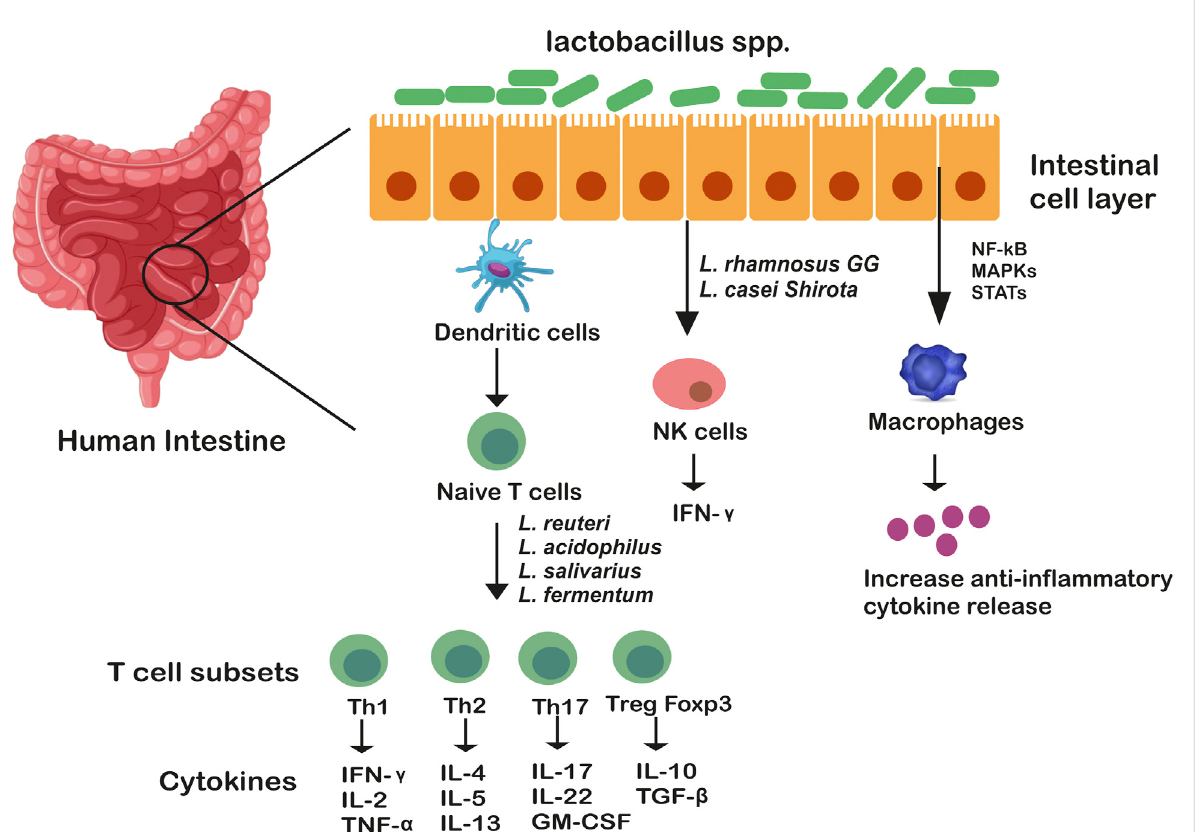
FIGURE 1 Genus Lactobacillus mediated immune modulation in the gut. Genus lactobacillus as whole bacteria or their components communicate through membrane receptors TLR-6 and TLR-2 which are expressed on macrophages and dendritic cells, stimulating T cell subsets differentiation. TheseTcells(Th1,Th2,Th17,Treg)areconsideredasthemastersofin fl ammation. Lactobacillus spp.alsoexerttheirfunctionsbyalteringintracellular pathways of immune cells (such as macrophages) through MAP kinases which either activate or suppress transcription factors, STAT, NF-kB, increasing anti-in fl ammatory cytokine